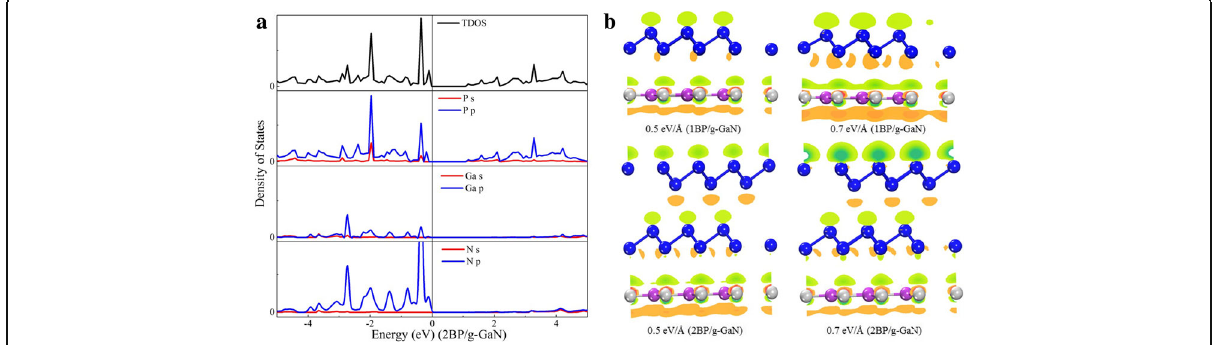
Fig. 5 a TDOS of bilayer-blue-P/g-GaN heterostructure. PDOS of P, Ga, and N in heterostructure. b Isosurface of charge accumulation and depletion of monolayer-blue-P/g-GaN heterostructure under E ext of 0.3 eV/Å, 0.5 eV/Å, − 0.3 eV/Å, and − 0.7 eV/Å,